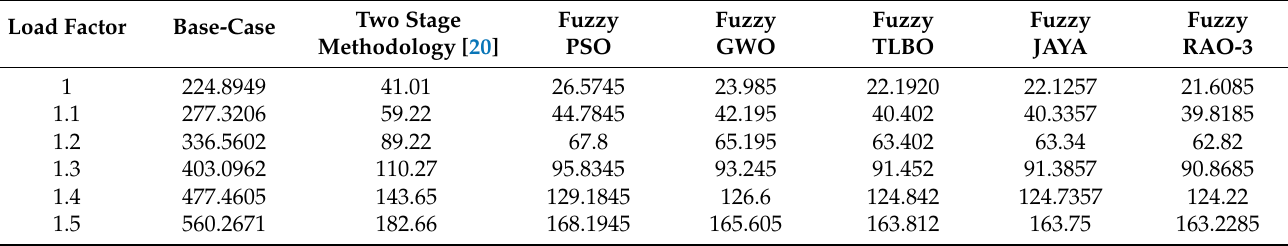
Table 12. The impact of the increased distribution load on the